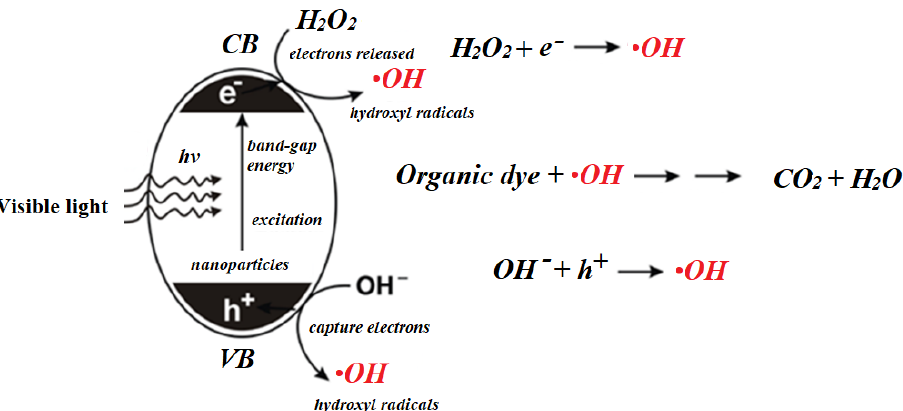
Figure 14. Generalized mechanism for the degradation of organic pollutants using NP-3 (Cu II0.4 Fe II0.6 Fe III2 O 4 ).